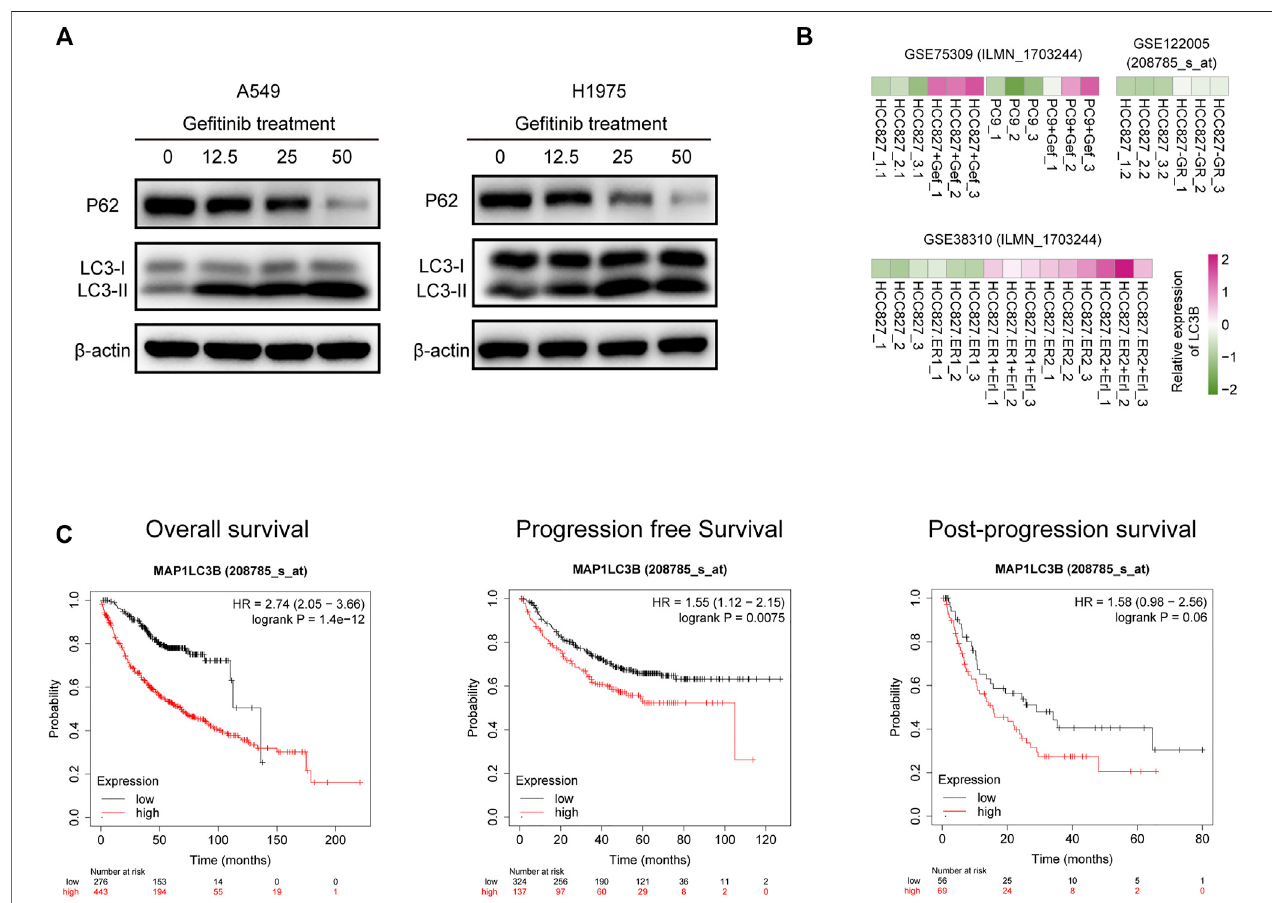
FIGURE 3 | LC3B expression is upregulated by ge fi tinib treatment and negatively correlated with prognosis of LUAD patients. (A) A549 ( left ) and H1975 ( right ) cells were treated with the indicatedconcentrationsofge fi tinib for 24 h, LC3Band P62proteinlevelwas detected bywesternblotting. (B) Heatmap representsLC3BmRNA expressionin HCC827, HCC827-ge fi tinib resistance (HCC827-GR), and PC9 cells treated with or without ge fi tinib (Gef), and HCC827-erlotinib resistance cells (HCC827-ER) treated with or without erlotinib (Erl). (C) Correlation of LC3B expression and Overall survival ( left ), progression-free survival ( middle ), and post-progression survival ( right ) in LUAD patients.